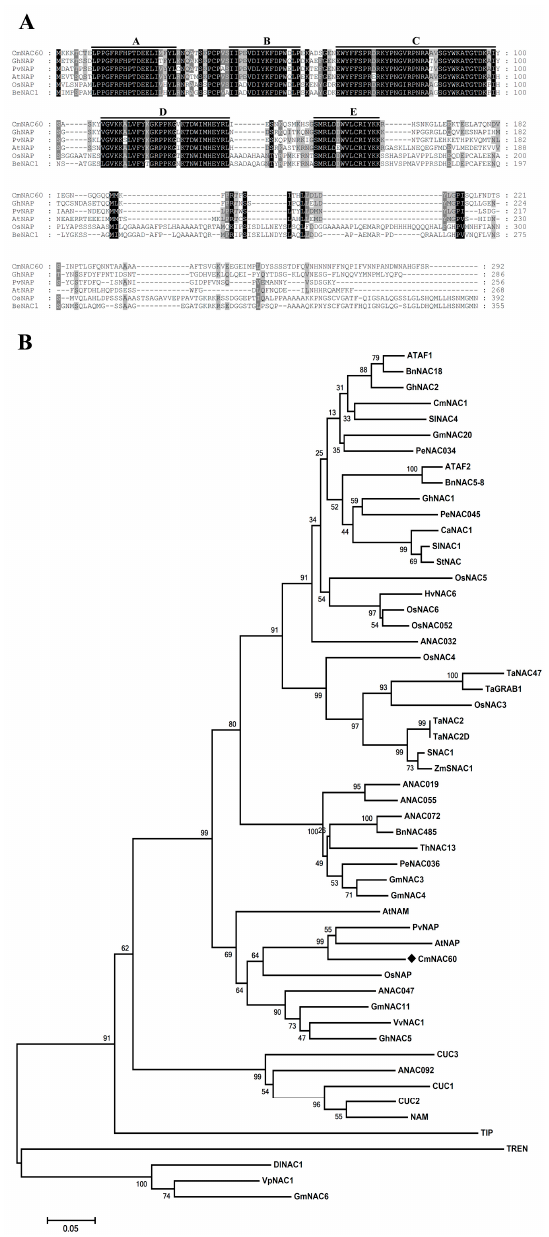
Figure 1. Multiple sequence alignment and phylogenetic analysis of CmNAC60 with other reported NAC protein sequences from di ff erent plant species that were functionally characterized. ( A ) Multiple sequences alignment of CmNAC60 with NAC protein sequences regulating leaf senescence from di ff erent plant species were aligned using the ClustalW2 software, and displayed with the GeneDoc software. Identical amino acids are shaded in black, and similar amino acids are shaded in gray. The locations of the five highly conserved amino acid motifs (A–E) are marked with overlines. ( B ) The phylogenetic tree was constructed from CmNAC60 with other di ff erent NAC proteins using MEGA5.0 with 1000 bootstrap replicates. Bootstrap support values are indicated on each node. CmNAC60 is labeled with a black